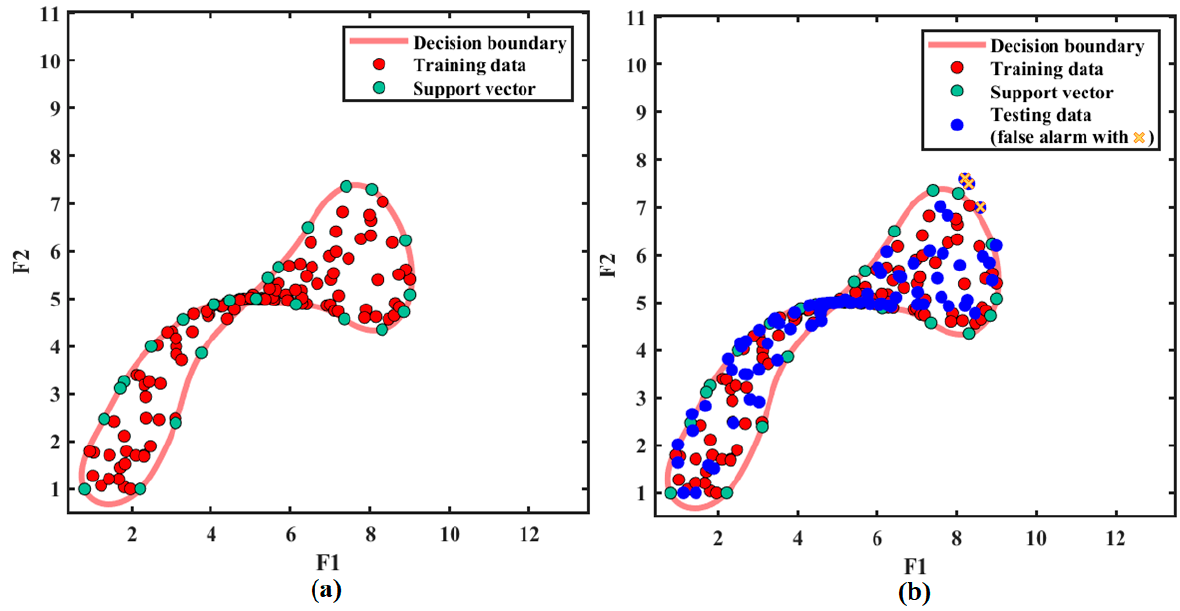
Figure 10. Classification results of clutter data set: ( a ) Training result; ( b ) Testing result.